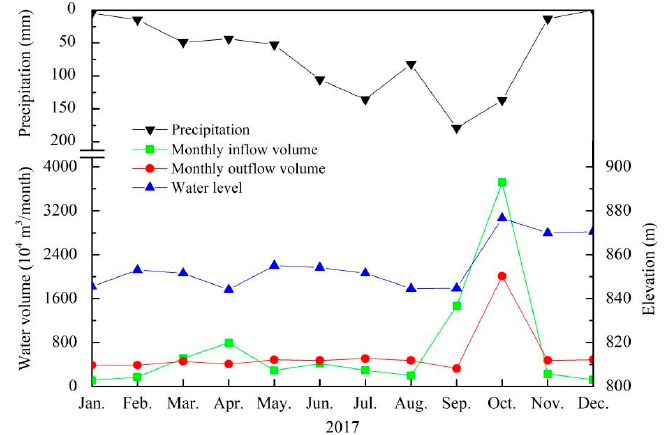
Figure 7. Variations in monthly precipitation, inflow volume, outflow volume, and water level in the Lijiahe Reservoir in 2017.